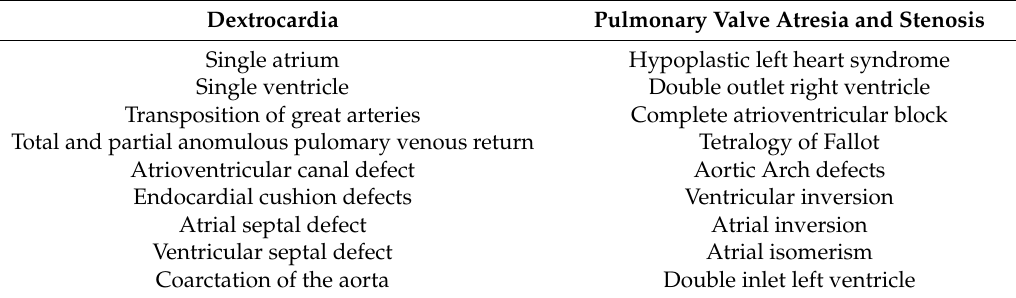
Table 2. Heart defects associated with abnormal laterality in humans